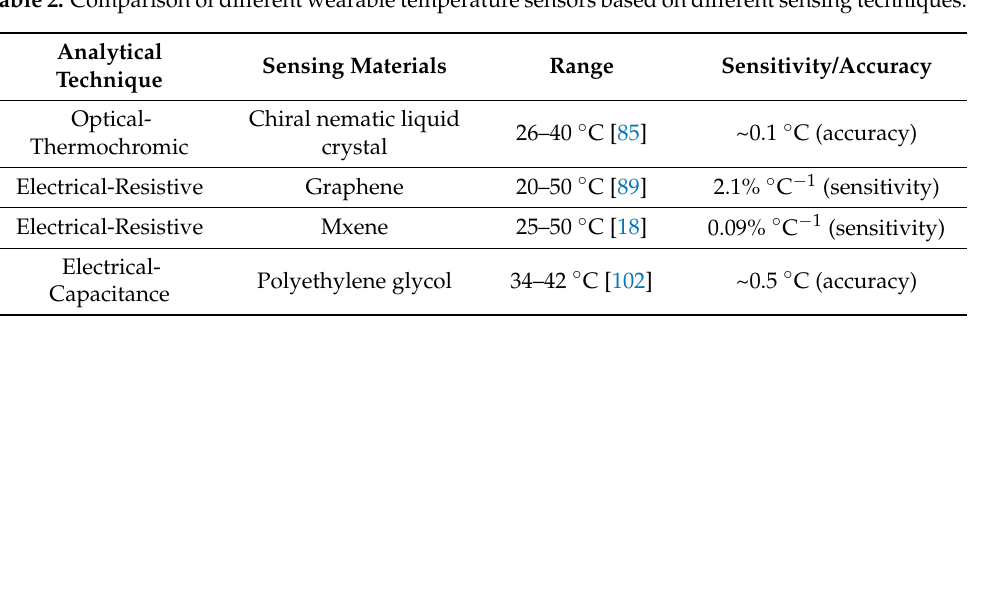
Table 2. Comparison of different wearable temperature sensors based on different sensing